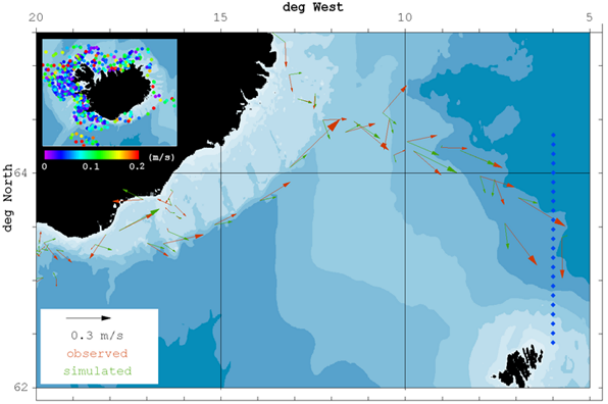
Fig. 5. Observed (red) and simulated (green) drift vectors at 15m depth southeast of Iceland between May 1998 and December 1999. Observed vectors are based on the surface drifter experiments by Valdimarsson and Malmberg (1999). The dotted blue line indicates the location of the surveyed cross-FC section (Hansen et al., 2010). Top left: The coloured dots denote the position of all analysed vec- tor pairs. The colour indicates the amount of the vector difference (observed minus simulated